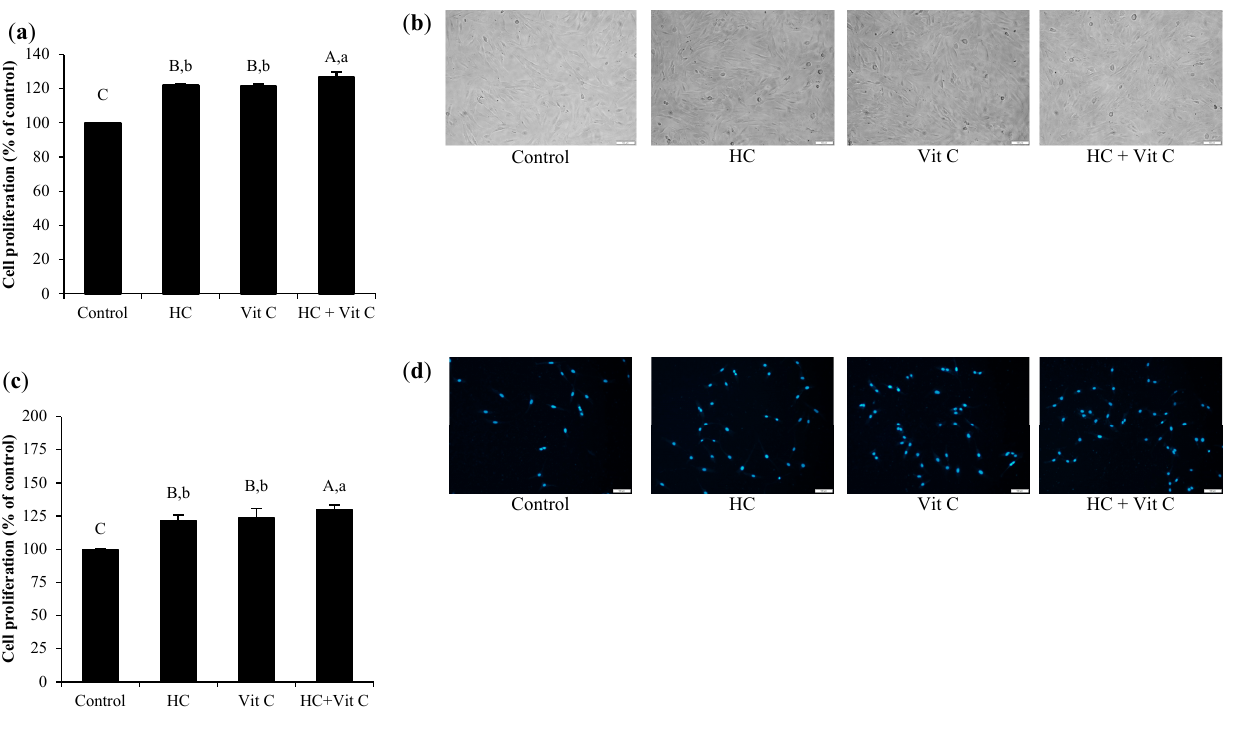
Figure 3. Effect of HC, Vit C, and HC combined with Vit C (HC+Vit C) at the selected levels on the proliferation of HDF cells determined using MTT assay ( a ) and cell morphology images ( b ). Double-stranded DNA (dsDNA) assay ( c ) and DNA staining images ( d ) after treatment with the different samples. The scale bar is 100 µm, and the magnification used is ×10. Bars represent standard deviation ( n = 3). Different uppercase letters on bars indicate significant differences between different samples tested and control ( p < 0.05). Different lowercase letters on bars indicate significant differences among different samples tested ( p < 0.05).